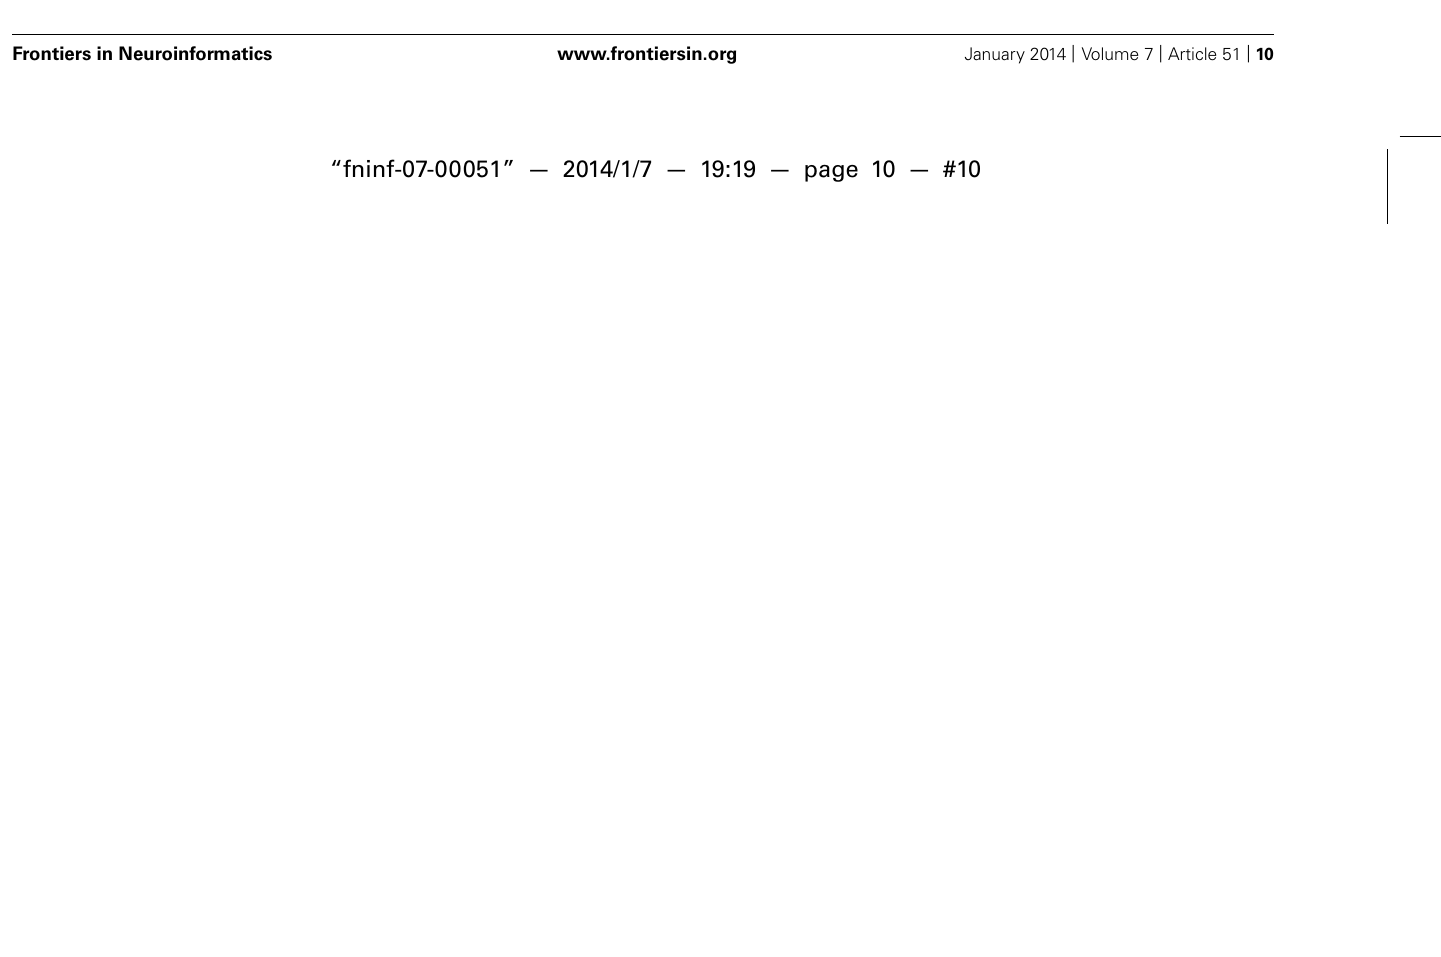
used to analyze the data for this paper are available with the sample data at